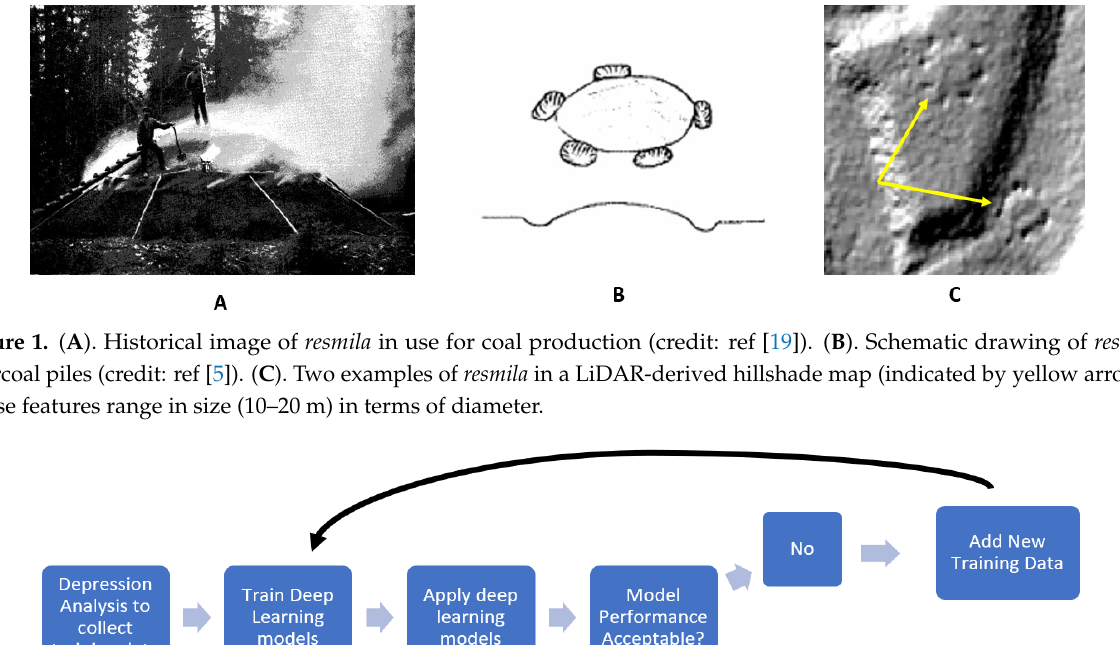
Figure 1. ( A ). Historical image of resmila in use for coal production (credit: ref [19]). ( B ). Schematic drawing of resmila charcoal piles (credit: ref [5]). ( C ). Two examples of resmila in a LiDAR-derived hillshade map (indicated by yellow ar- rows). These features range in size (10–20 m) in terms of diameter.